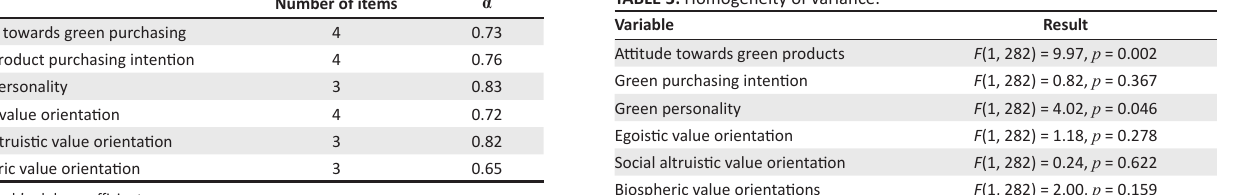
TABLE 3: Homogeneity of variance.